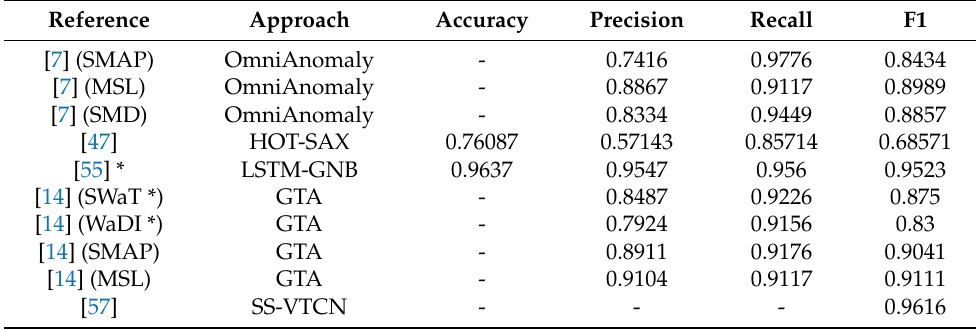
Table 10. Performance of surveyed works for time series data application. An * indicates averaged data.